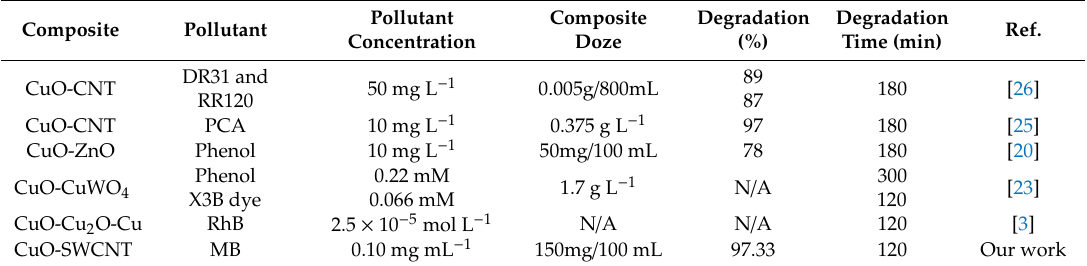
Table 2. Comparison of photocatalytic performance of our photocatalyst with other CuO based catalysts. Composite